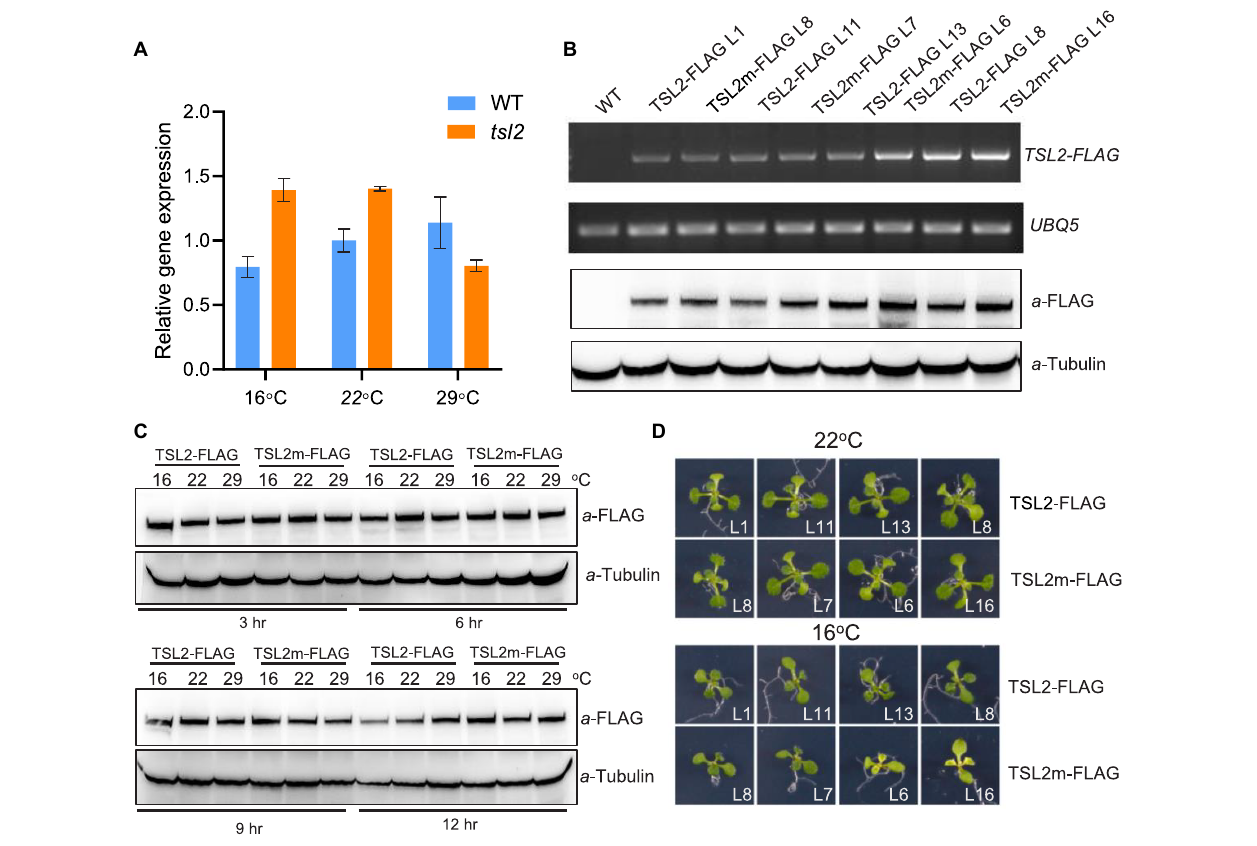
FIGURE 4 | Mutation of TSL2 does not affect TSL2 protein accumulation. (A) RT-qPCR detection of TSL2 expression in wild-type (WT) and tsl2 mutant plants. The seedlings grown at 22 ◦ C for 4 days were kept at 22 ◦ C or transferred to 16 or 29 ◦ C for 7 days, and collected for RT-qPCR analysis. The TSL2 expression was normalized to the WT sample (22 ◦ C), both of which were normalized to the expression of PP2A . Error bars represent SE ( n = 3). (B,C) Protein accumulation of TSL2-FLAG and TSL2m-FLAG. Various transgenic lines grown at 22 ◦ C for 10 days were collected for RT-PCR and western blotting analysis. UBQ5 gene was used as the control. Transgenic plants (TSL2-L1 and TSL2m-L8) grown at 22 ◦ C for 10 days were transferred to 16, 22, or 29 ◦ C for the indicated time, and total proteins were extracted for western blotting. Tubulin was used as a loading control. (D) Phenotype of TSL2-FLAG and TSL2m-FLAG overexpression lines. The transgenic plants were grown at 22 ◦ C for 4 days and transferred to 16 ◦ C or kept in 22 ◦ C for 10 days and photographed. The mutated form of TSL2 (A939T) was amplified from the tsl2 mutant.